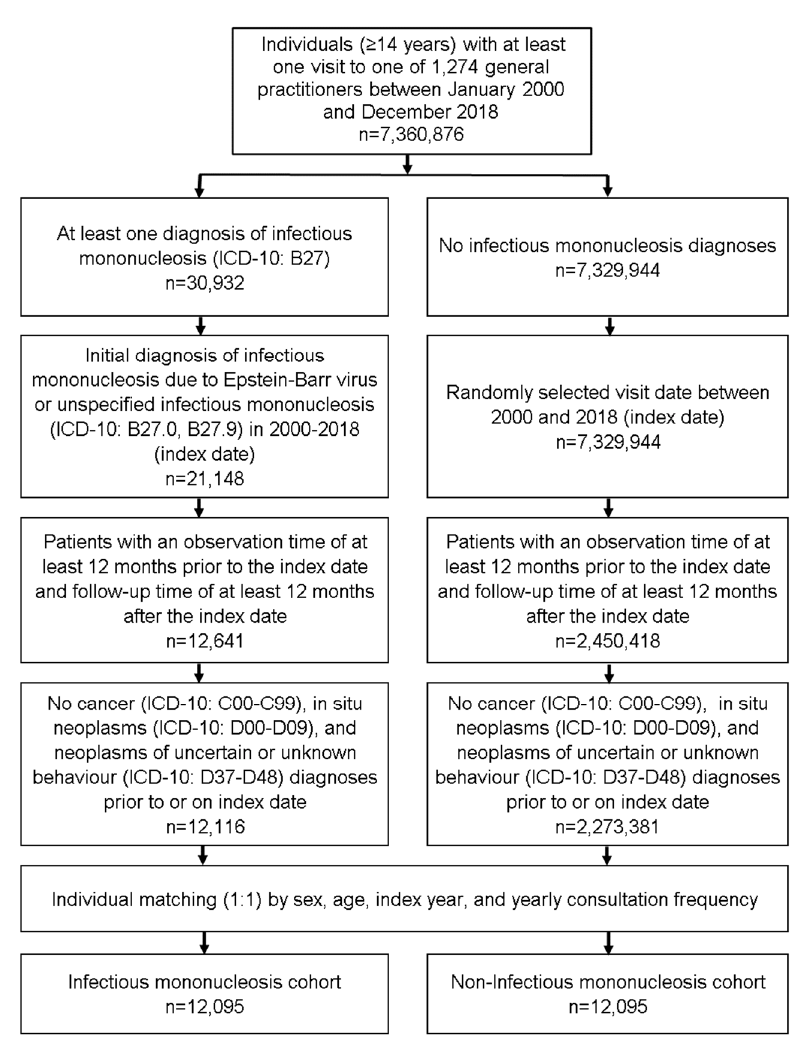
Figure 1. Selection of study